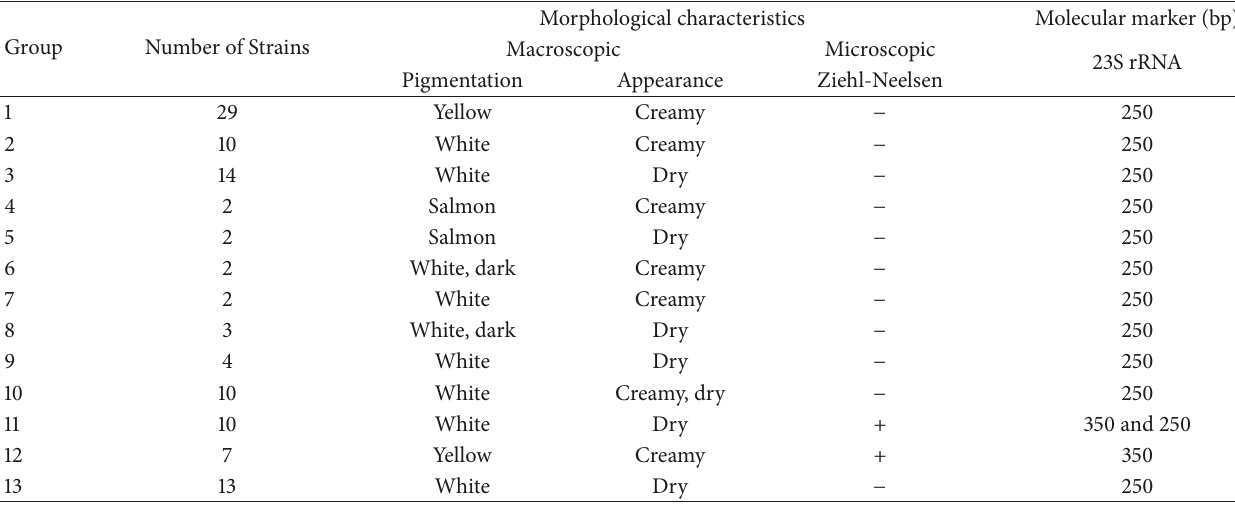
Table 2: Isolated strains are grouped according to their morphological characteristics and the presence of the molecular marker (100 bp) on the 23S rRNA gene.